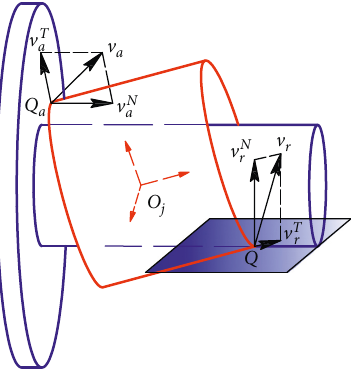
Figure 9: Relative velocity in 3D joint with